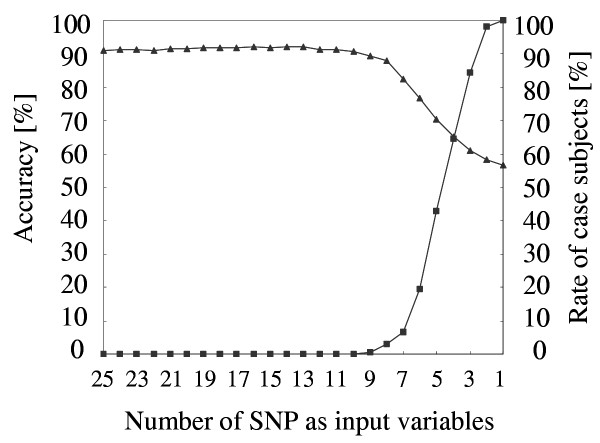
Effect of number of input variables on ANN model accuracy during PDM procedure. Closed triangles represent average accuracy for learning and evaluation data. Closed squares represent the rate of case subjects that means N'case/Ncase. In this case, N'case is the number of cases whose genotype pattern is match to control's genotype pattern at least one control (Ncase = 172 subjects).